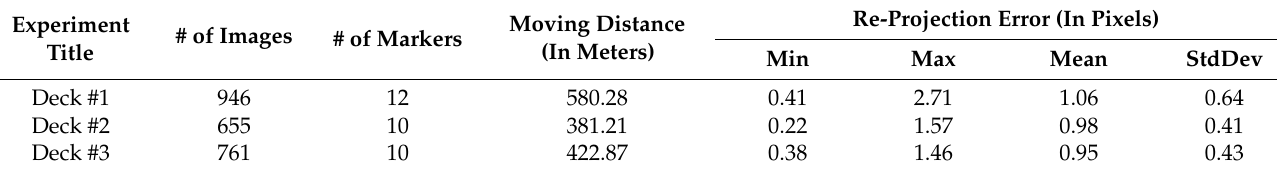
Figure 13. Concept of transforming global optimized markers into CAD coordinate system. Table 1. Accuracy evaluation using re-projection error check.